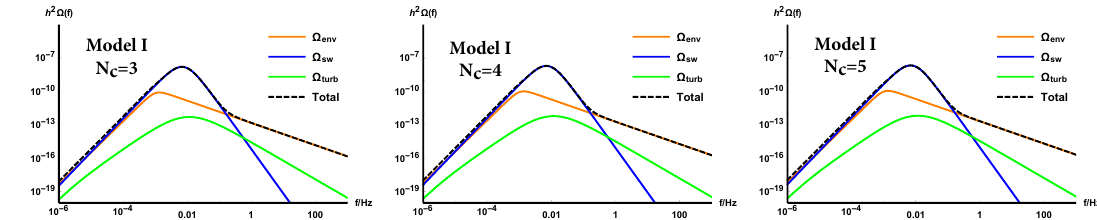
Figure 4 . The GWs spectrum or the energy density of the GWs as a function of the frequency produced from the (cid:12)rst order EW phase transition, with the parameters listed in Model I of the holographic technicolor model for N TC = 3, N TC = 4 and N TC = 5,